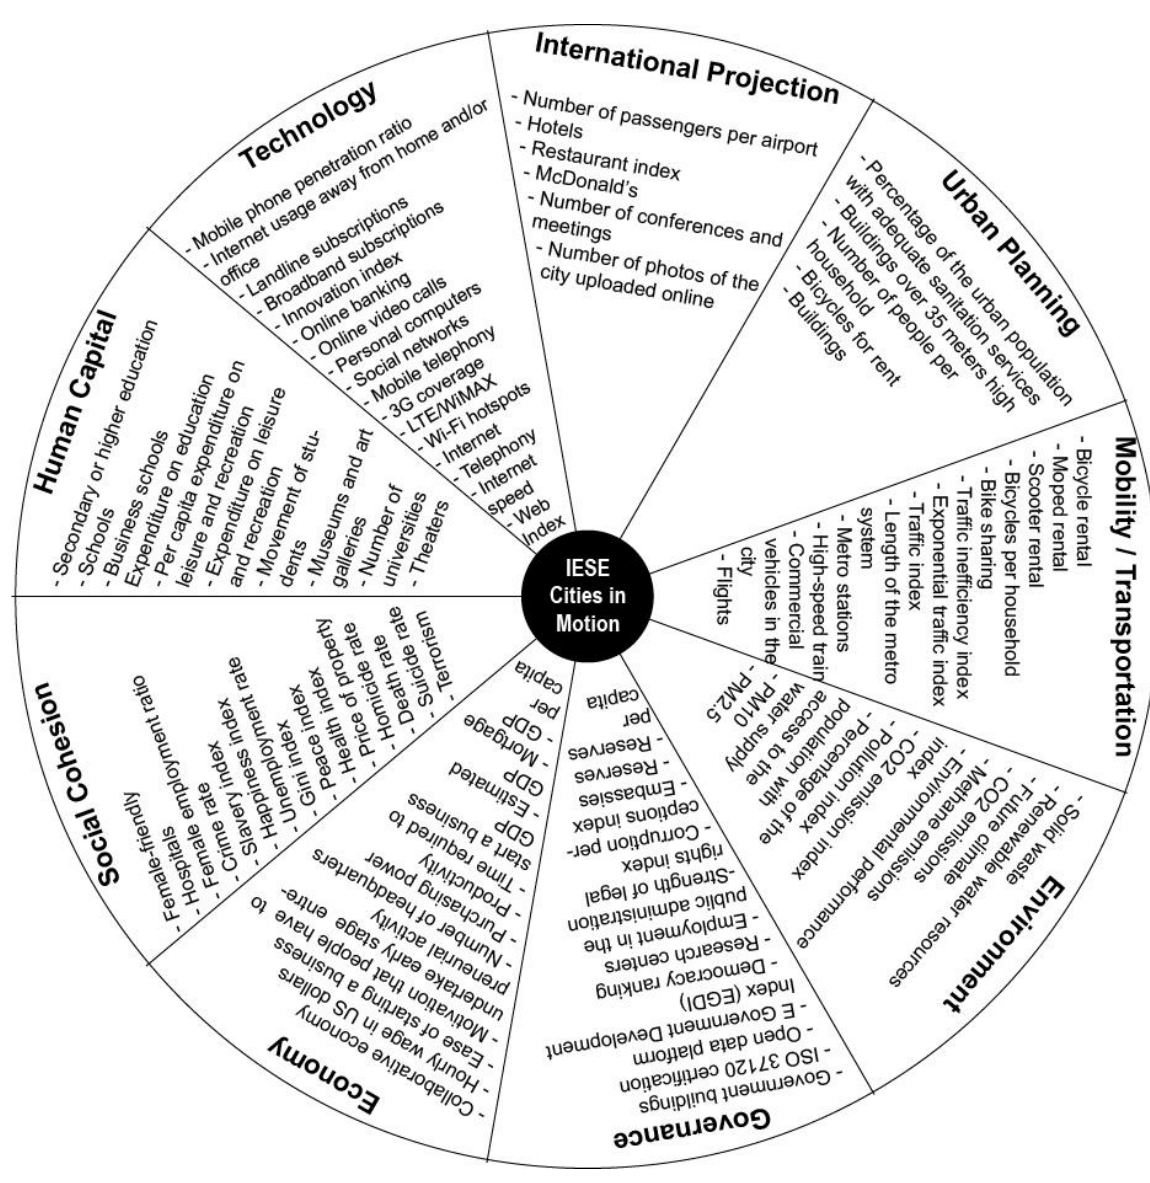
Figure 8. Cities in Motion ranking by IESE. Source: [116]. Adapted by the author.